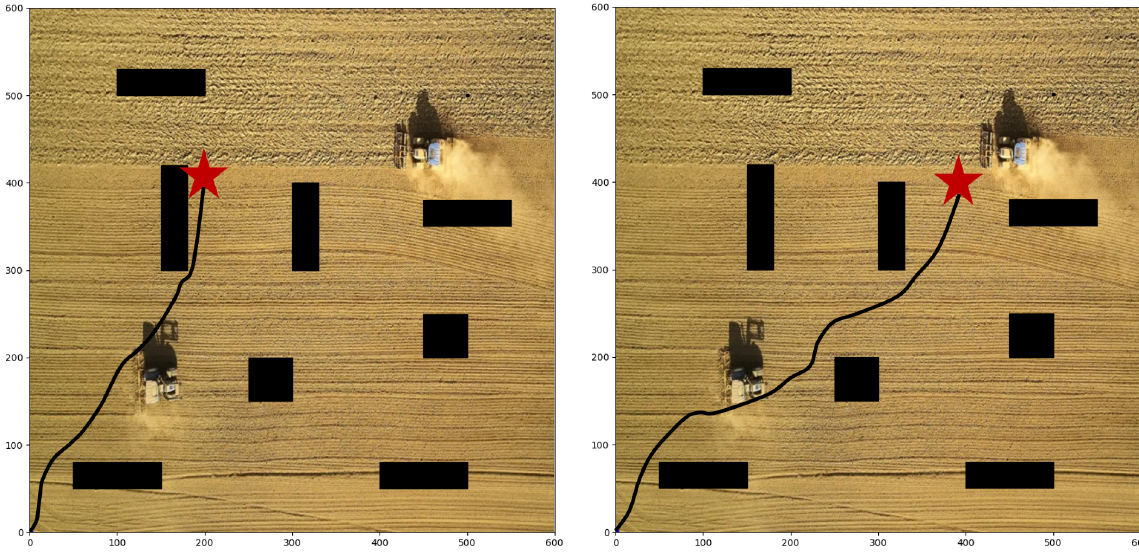
Figure 8. The planned paths with target point of (200, 400) and (400,